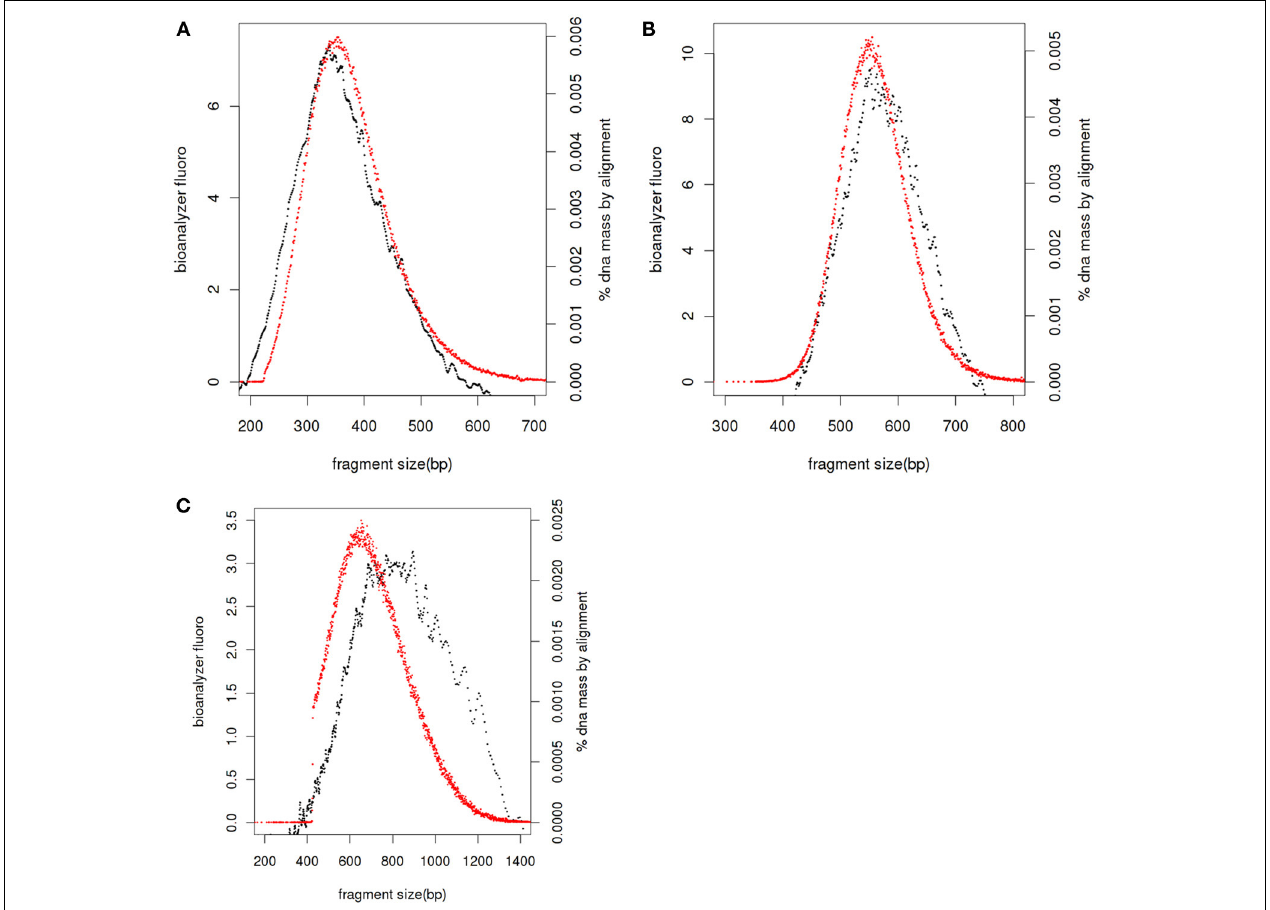
FIGURE 2 | Library fragment size distribution. Bioanalyser fluorescence values (black), realignment of paired end reads against reference genome or de novo assembly and adjusted by 126 bases to account for adapters (red) for libraries with average sizes of 360 bases (A) , 550 bases (B) , and 810 bases (C)